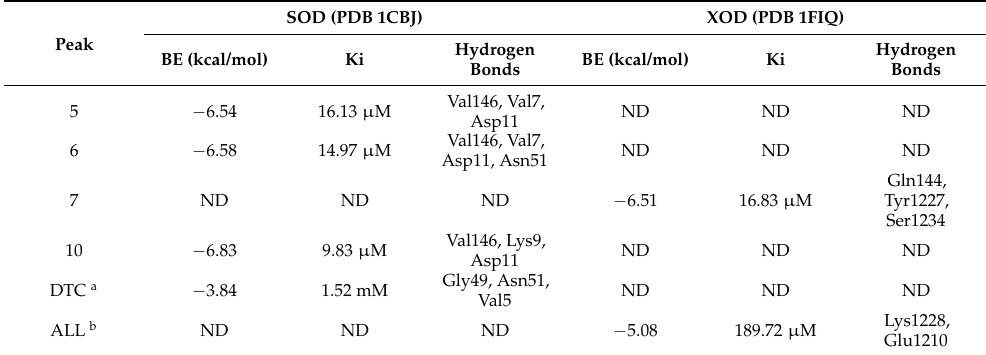
Table 3. The molecular docking results of the potential ligands in P. sibiricum with SOD and XOD. SOD (PDB 1CBJ) XOD (PDB 1FIQ) Peak BE (kcal/mol) Ki Hydrogen